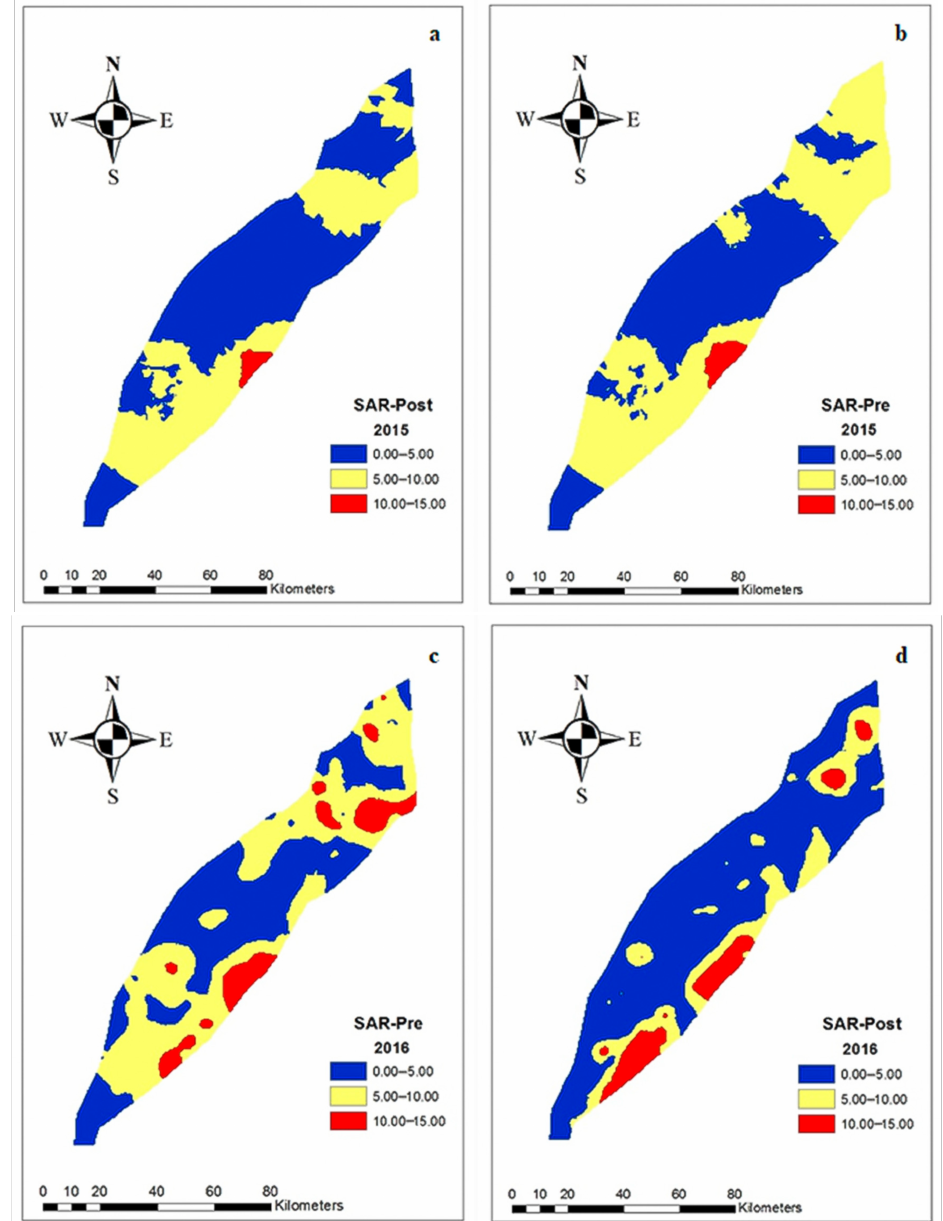
Figure 6. Spatial distribution of groundwater SAR ( a ) for post-monsoon season in 2015 ( b ) for pre-monsoon season in 2015 ( c ) for pre-monsoon season in 2016 ( d ) for pre-monsoon season in 2016. In 2015, the overlay analysis for SAR indicated that the upper part of the north-east and lower south-east and south-west zones had a higher concentration of SAR mainly in pre-monsoon season (Figure 7a). In 2016, the overlay analysis for SAR indicated that the upper north-east zone had a higher concentration of SAR in both the seasons, and the value of SAR in this zone was greater than 15 (Figure 7b). The spatial distribution of groundwater level (GWL) for the pre-monsoon season in 2015 indicated that GWL was high over the lower south-east part of the study area (Figure